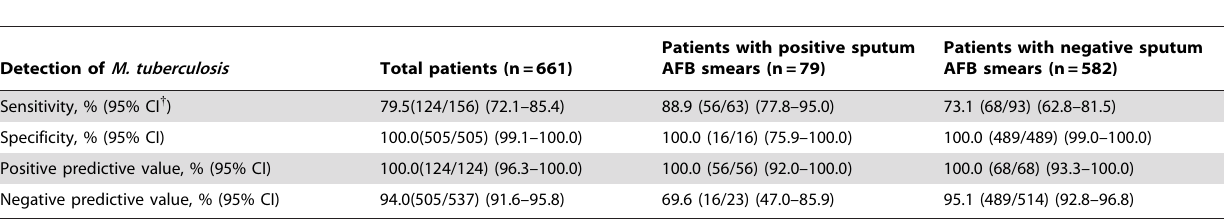
Table 2. Diagnostic accuracy of the Xpert MTB/RIF assay using sputum specimens for the diagnosis of pulmonary tuberculosis (Bacteriologically confirmed cases).